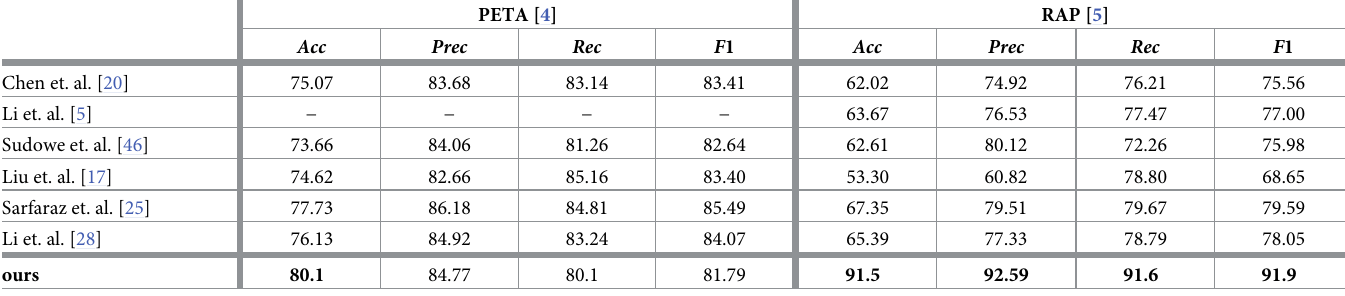
Table 3. Quantitative results (%) on PETA and RAP datasets. Results are compared with the other benchmark methods. As can be seen, we have comparable results, with considerable improved accuracy for both the